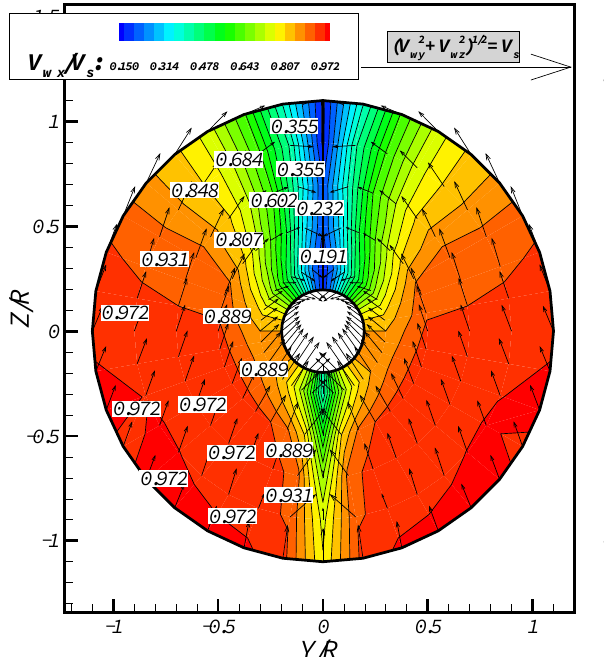
Fig. 7.45: Seiun-Maru effective ship wake. Figure 11. Seiun–Maru ship effective wakefield. (Image republished from [19] with permission of the